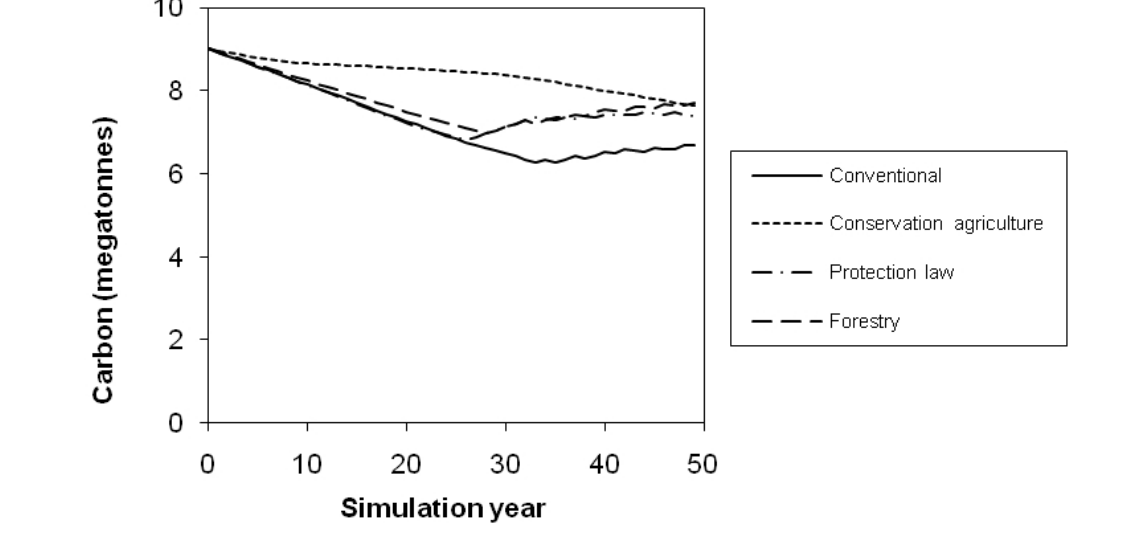
Fig. 4 . Simulated aboveground biotic carbon storage in the Cuenca under four land use